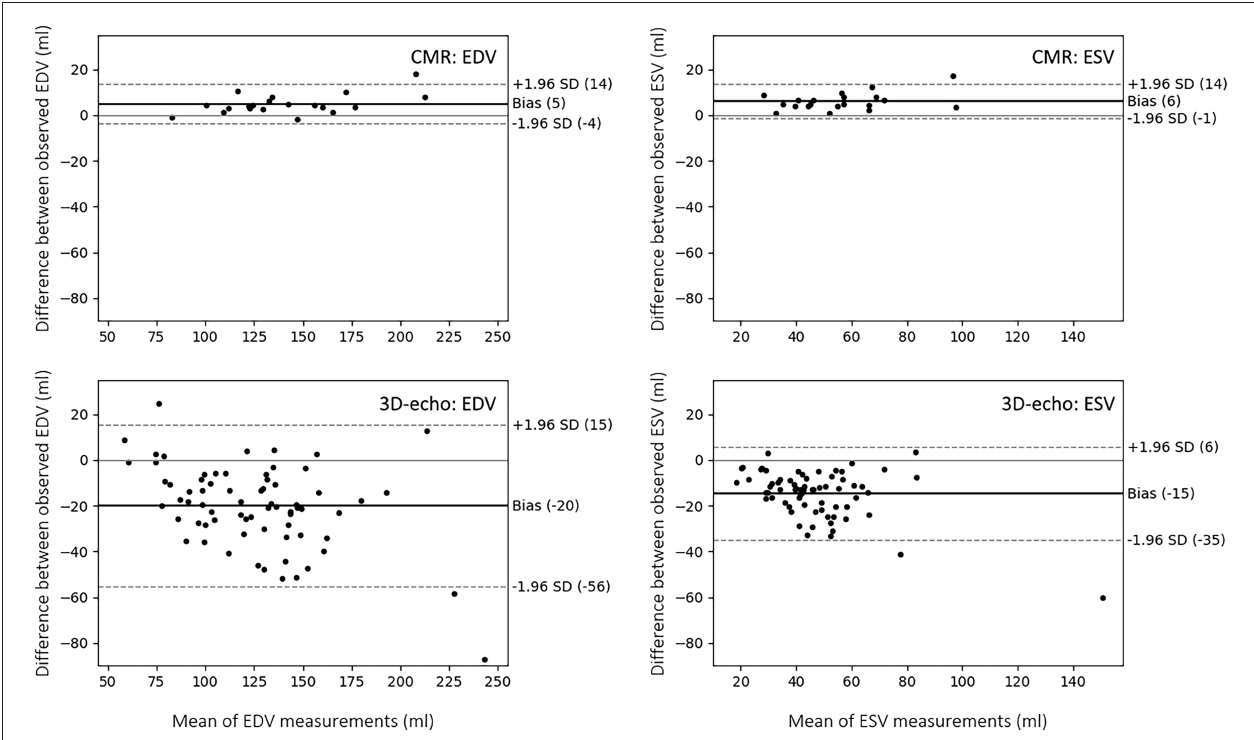
FIGURE 8 | Bland-Altman plots showing limits of agreement and biases between two observers in the analysis of LV volume from CMR (using CIM) and 3D-echo (using TOMTEC). The limits of agreement represent the values between which 95% of the differences are expected to fall.